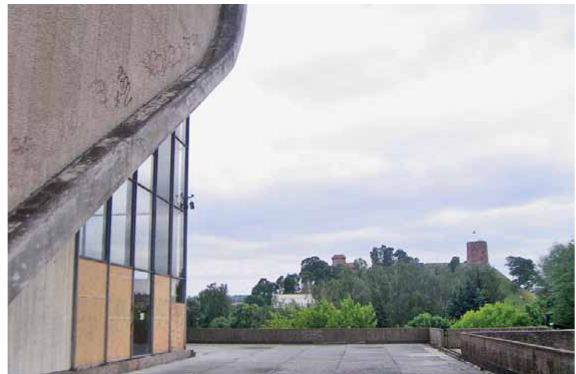
Fig. 6. outdoor terrace of the Concert and Sports Palace with a view to the historic castle territory of Vilnius. Fig 7. View of Congress Hall in Berlin (Haus der Kulturen der Welt at present). frank Paul photo. access via